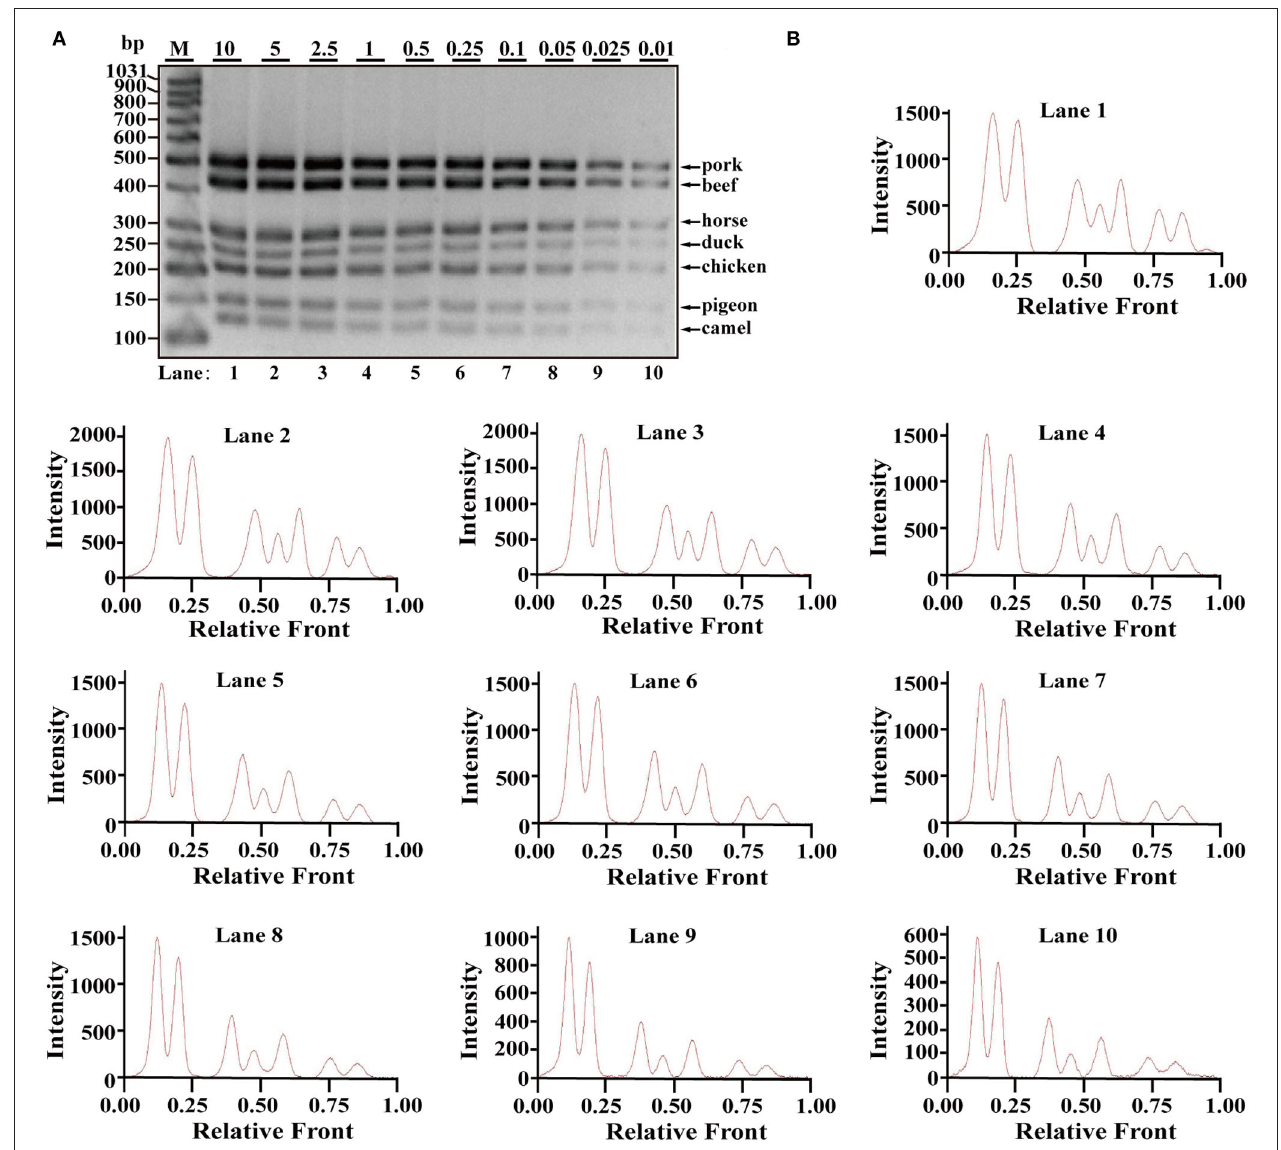
FIGURE 2 | Validation of the sensitivity of multiplex PCR assay. (A) Gel image of PCR fragments amplified by multiplex PCR using premixed DNA templates of seven species (10, 5, 2.5, 1, 0.5, 0.25, 0.1, 0.05, 0.025, and 0.01 ng) with species-specific primers of seven meat species in a single PCR. (B) The corresponding electropherogram of gel image represented pork, beef, horse, duck, chicken, pigeon, and camel in each lane. Lanes 1–10 are presented with labels (10, 5, 2.5, 1, 0.5, 0.25, 0.1, 0.05, 0.025, and 0.01) in (A) . The value of number at the horizontal line means the relative position of peaks distant from the top of agarose gel. The value of number at the vertical line means the fluorescent intensity of DNA-bound dyes using 4S GelRed nucleic acid stain. Lane M is ladder DNA.